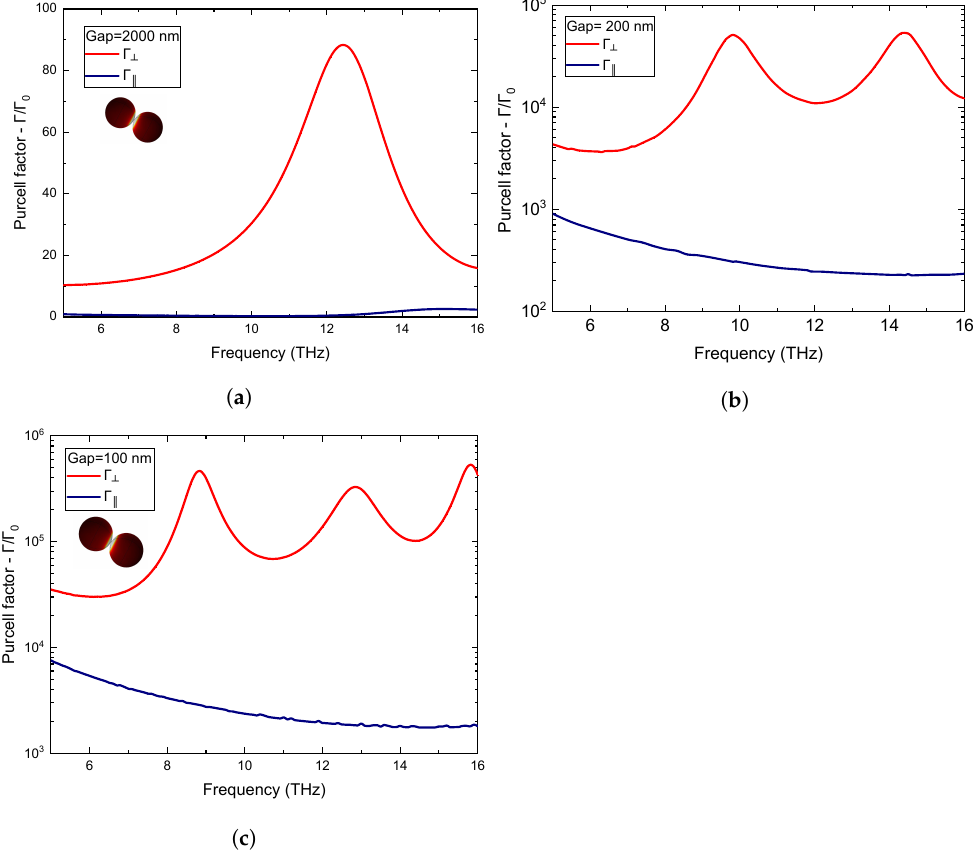
Figure 2. The Purcell factors for a dipole which is normally and tangentially oriented with respect to the surfaces of a dimer of Bi 2 Te 3 microspheres with 2 µ m radius, as a function of EM mode frequency of the QE and gap distance: ( a ) Gap = 4000 nm, ( b ) Gap = 200 nm, ( c ) Gap = 100